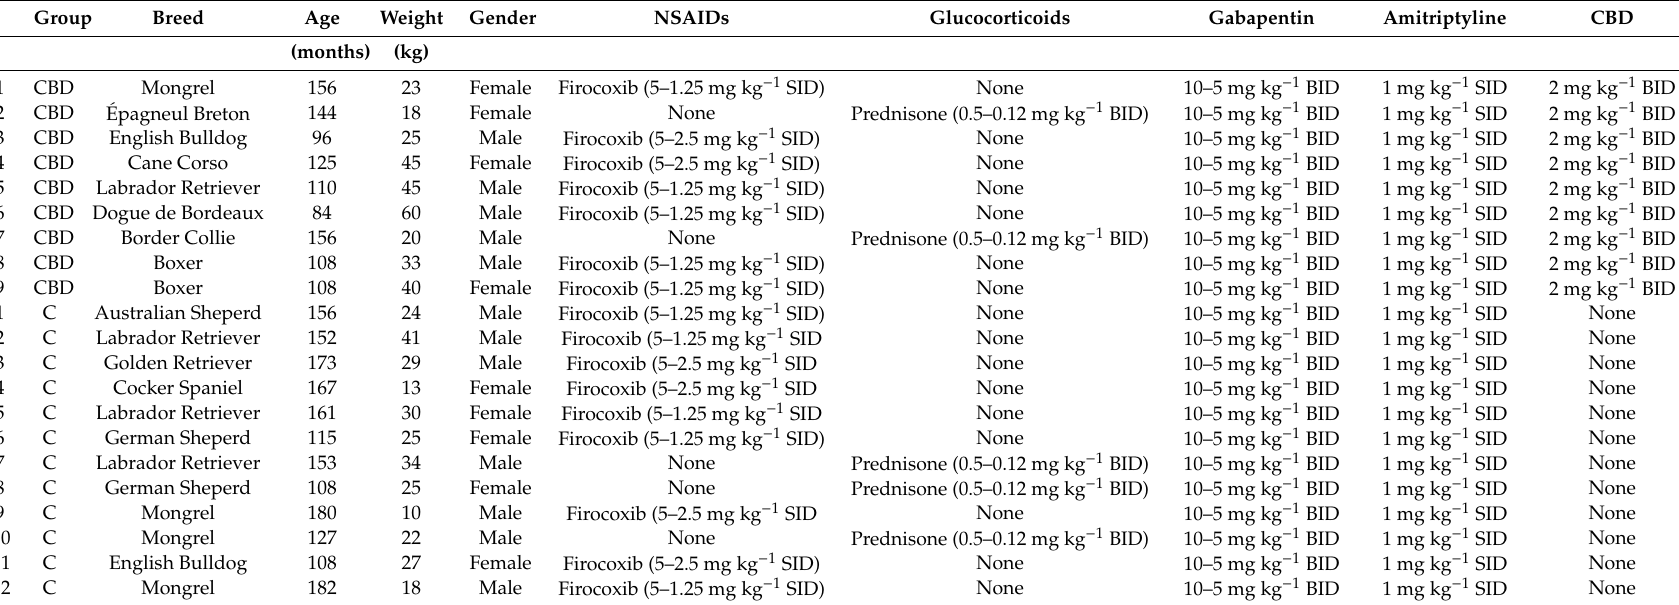
Table 2. Breed, age, weight, gender and analgesic therapies administered to the dogs recruited in CBD ( n = 9) and C ( n = 12) groups. SID, once daily; BID, twice daily.